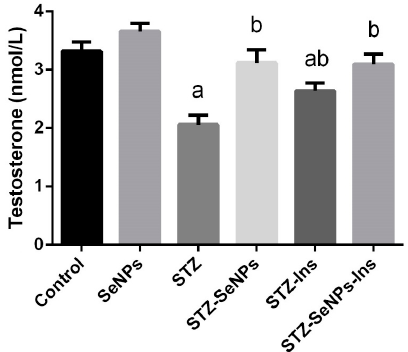
Figure 2. Impact of SeNPs and/or insulin on the serum testosterone levels in control and STZ-diabetic rats. Values are mean ± SEM ( n = 7). a p < 0.05, significant change with respect to Control group; b p < 0.05, significant change with respect to Diabetic group.